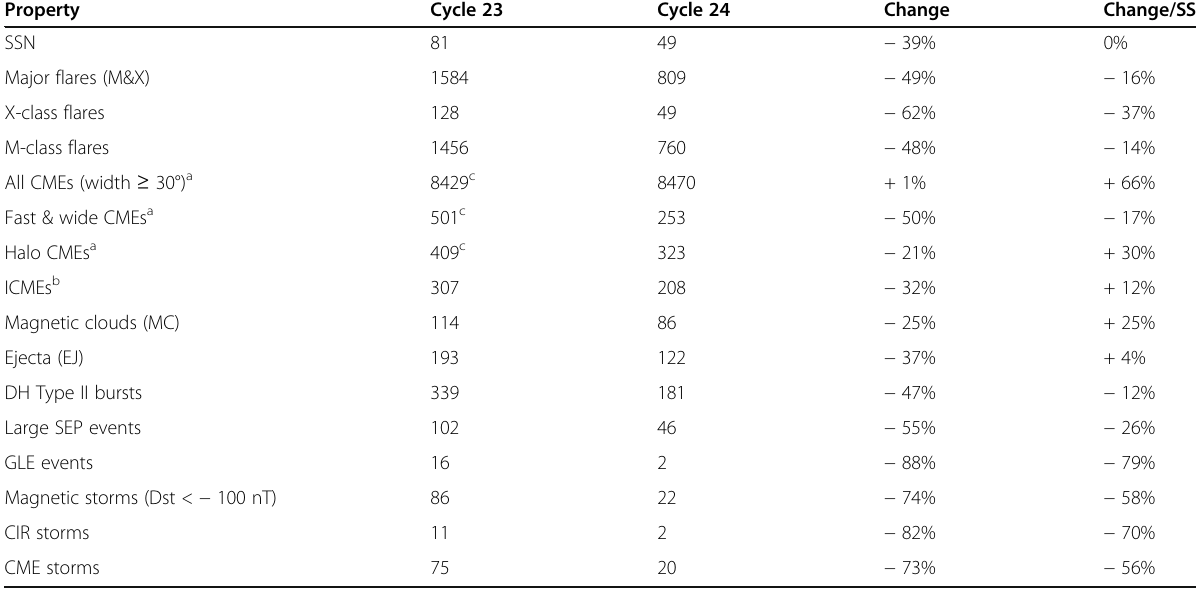
Table 2 Earth-affecting events in solar cycles 23 and 24 in comparison with the SSN